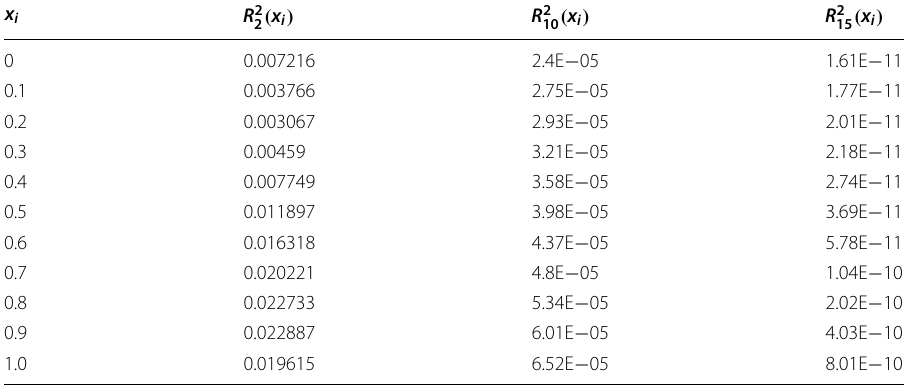
Table 10 The absolute errors R 2 n ( x i ) for n = 4, 6 x